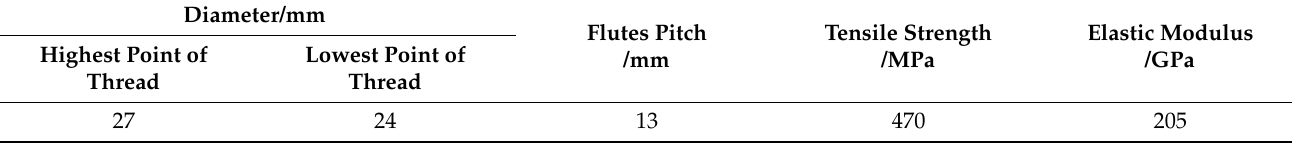
Table 3. Mechanical properties of the steel bar.